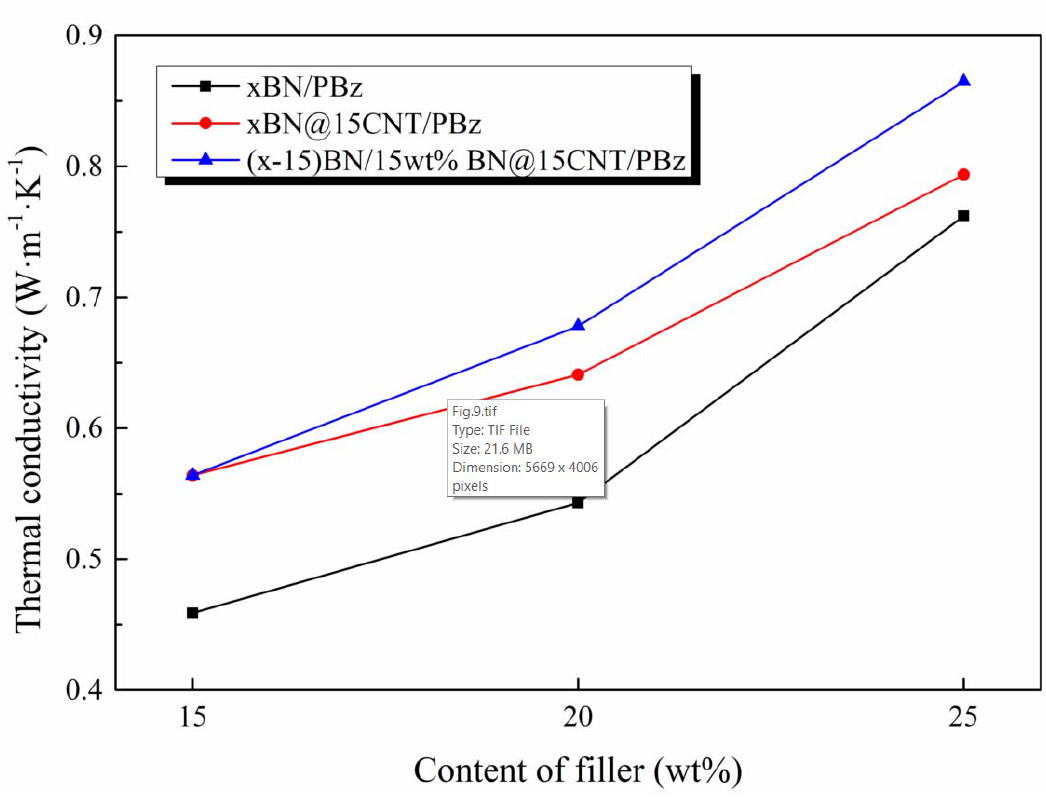
/ BN@15CNT / PBz composites.